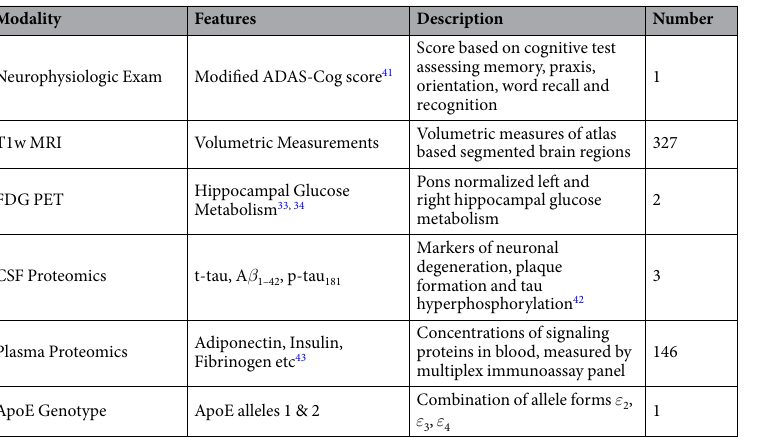
Table 4. Summary of features considered in this study from each